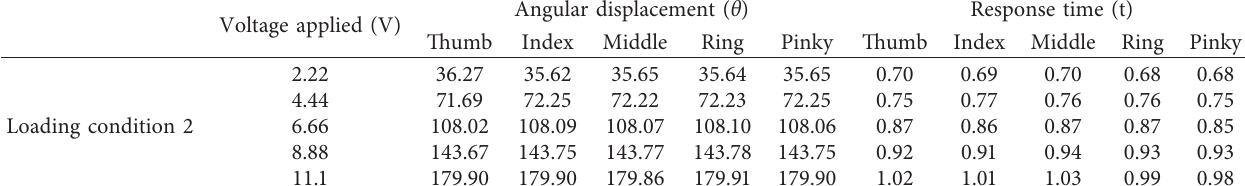
Table 2: Electrical parameter combination for loading condition 1.